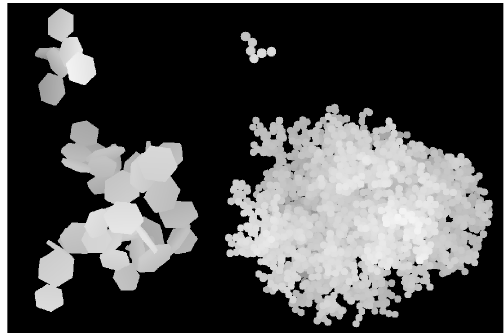
Fig. B1. Image showing two hexagonal plate aggregates (left) and two sphere aggregates (right). The plate aggregates are made of 6 thinner plates and 40 thicker plates. The sphere aggregates have 6 and 3600 spheres. The lighter shades indicate the closer parts of the particle, and the darker shades indicate the farther